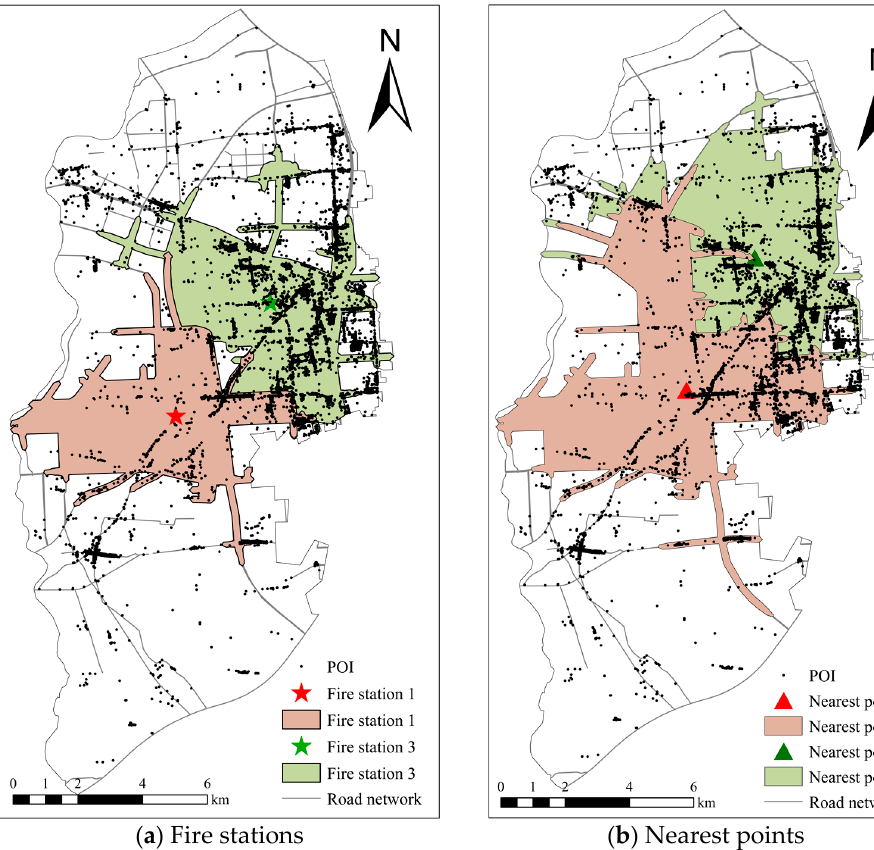
Figure 7. Coverage of area.